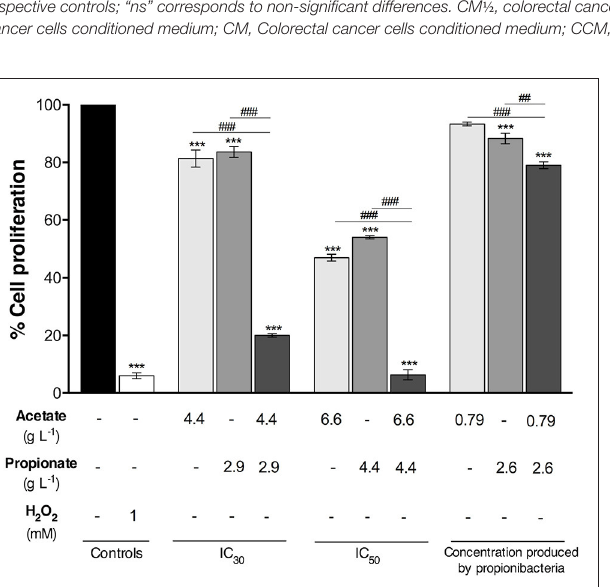
FIGURE 3 | Proliferation of colorectal cancer cells treated with pure acetate and propionate either alone or combined. Cells were incubated for 48h with IC 50 , IC 30 and the acetate and propionate concentrations similar to the ones that were determined in the Propionibacterium freudenreichii fermented broth. Fresh DMEM medium and hydrogen peroxide (1mM) were used as a negative and positive control, respectively. Values represent the mean ± standard error of the mean of at least three independent experiments.*** p < 0.001, compared with negative control cells. ## p < 0.01, ### p < 0.001, comparing between